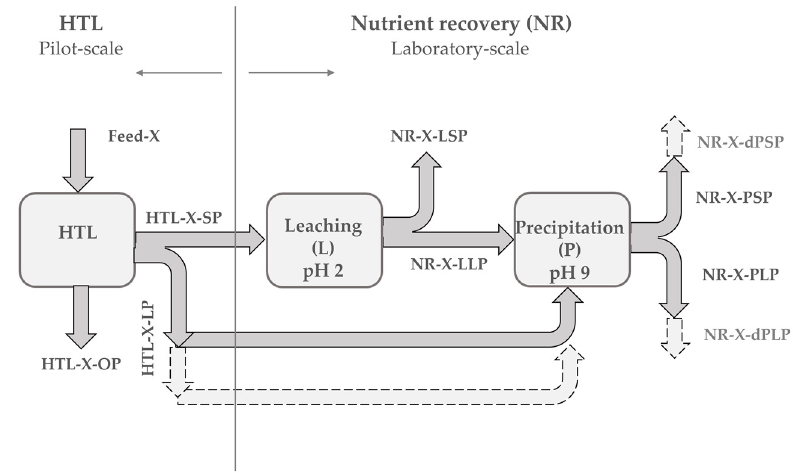
Figure 1. Simplified sample flow diagram and sample ID. SP solid phase; LP liquid phase; OP oil phase. X corresponds to primary sewage sludge (PSS) or Spirulina ( SPR ) and d to